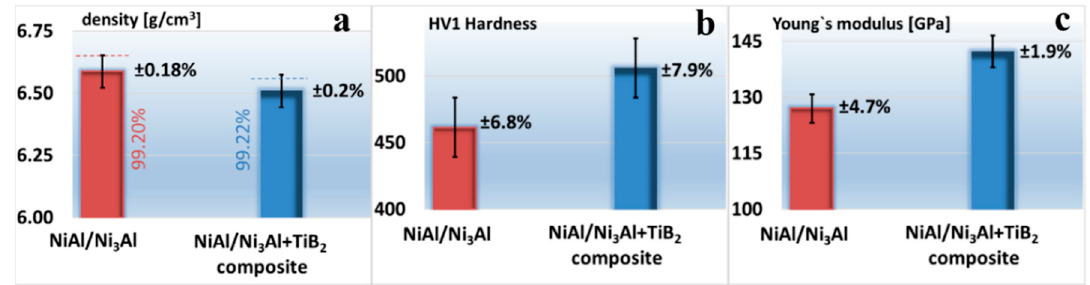
Figure 6. Comparison of selected properties of the sintered matrix material and composite: ( a ) density, ( b ) hardness, ( c ) Young’s modulus.